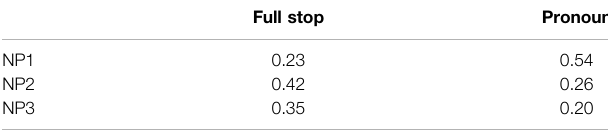
TABLE 9 | Proportion of next-mention in Experiment 3, per referent, per prompt